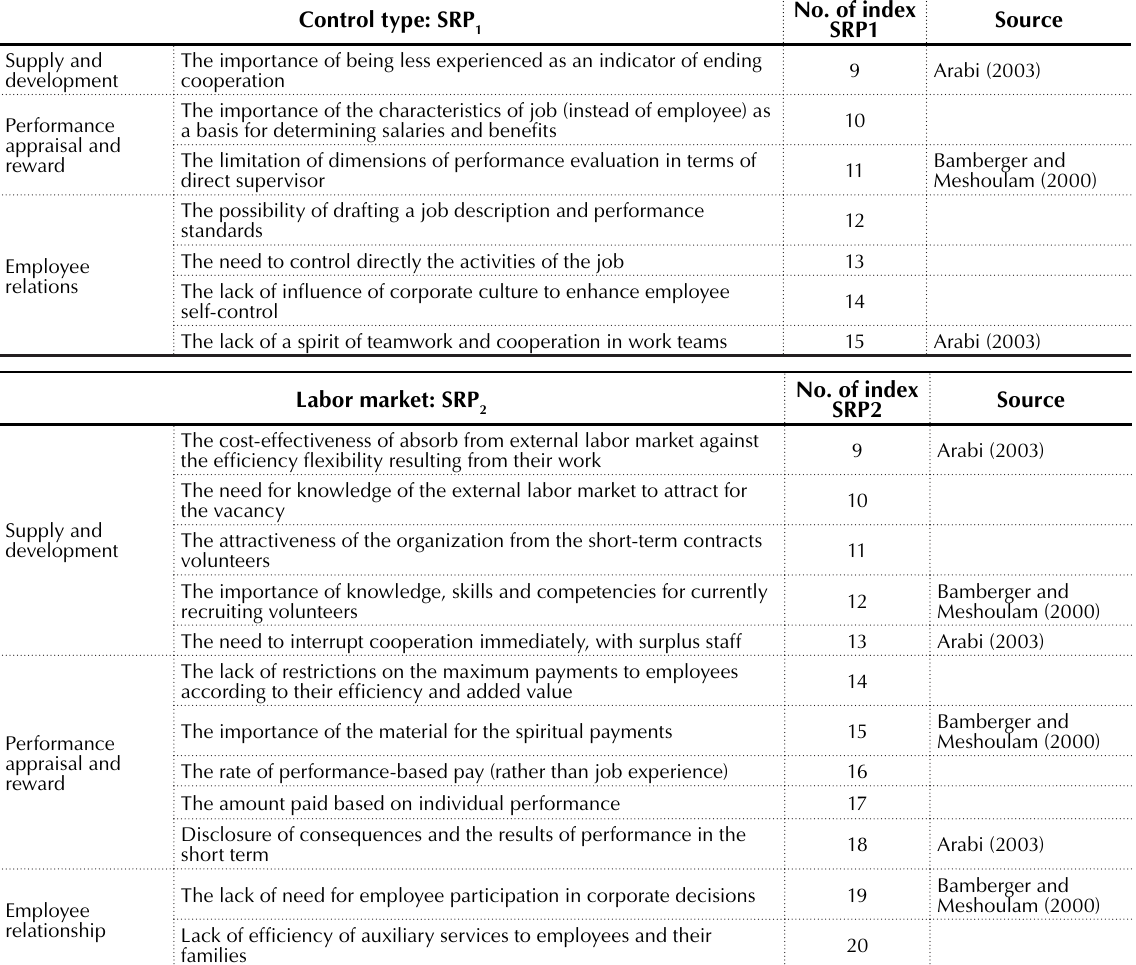
Table 3. Secondary SRPs (indices) divided by category (HR sub-systems) Control type: SRP 1